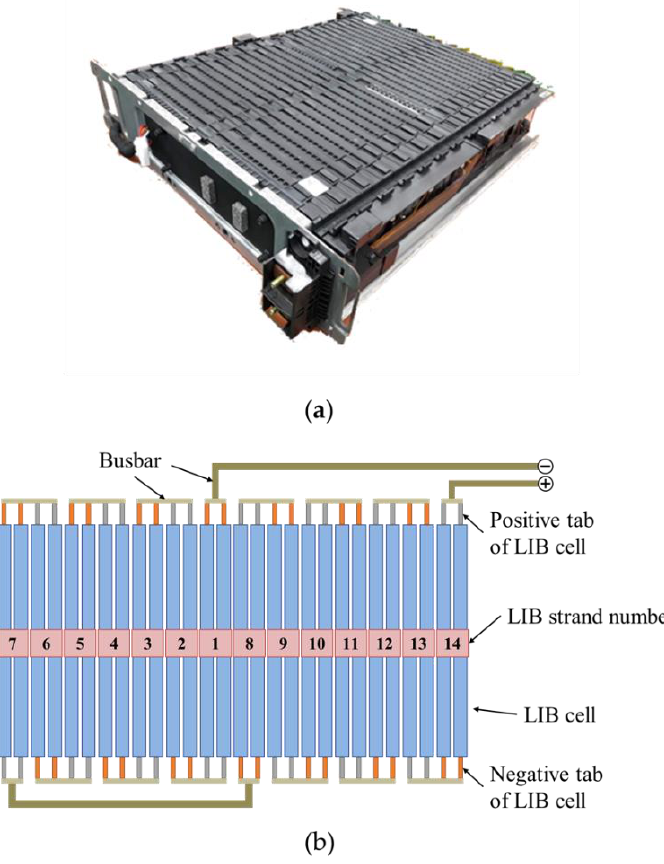
Figure 2. ( a ) Photograph of an LIB module with LIB cells configured in two parallel and 14 series and ( b ) schematic of the electrical connections of the LIB module.